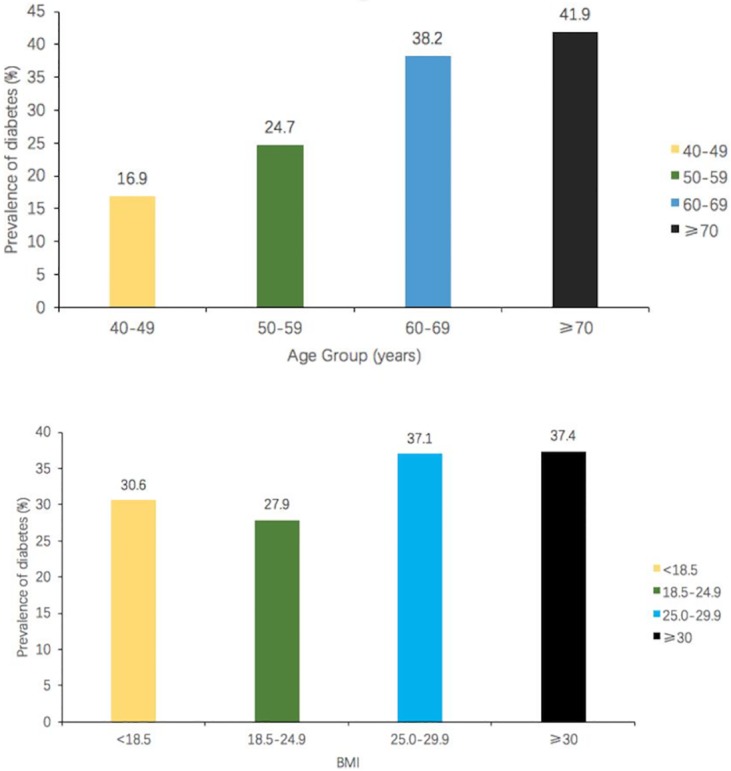
DM prevalence in hypertensive patients aged 40 to 79 years gradually increased with age and BMI.